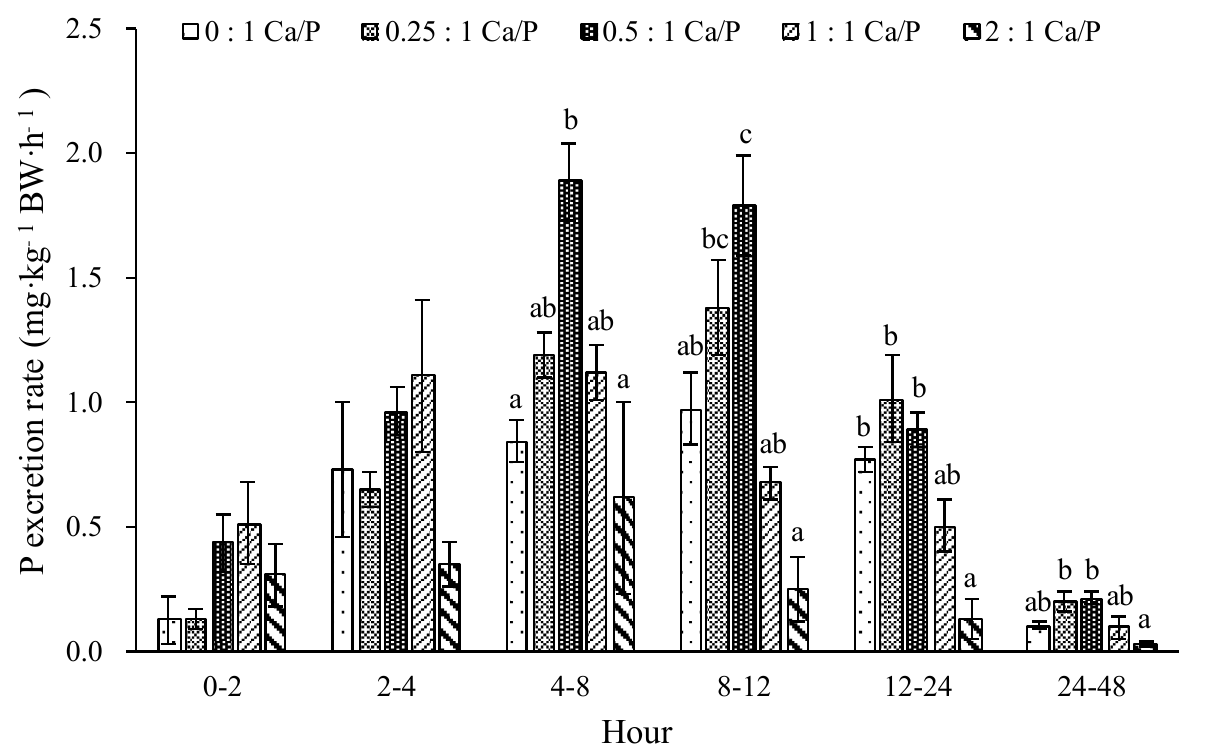
Figure 3. Phosphorus (P) excretion rate of hybrid sturgeon ( Huso dauricus ♀ X Acipenser schrenckii ♂ ) after being intubated with 100 mg P·kg − 1 BW at different Ca/P ratios. Different letters indicate significant differences among the treatments for each sampling time ( p < 0.05).